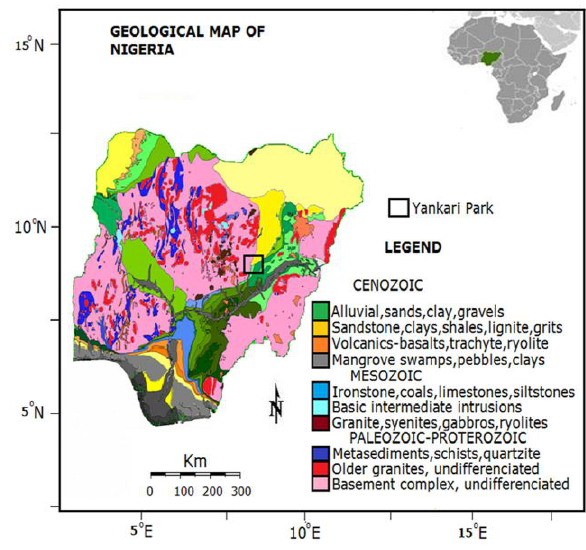
Figure 1. Geological Map of Nigeria showing the location of Yankari